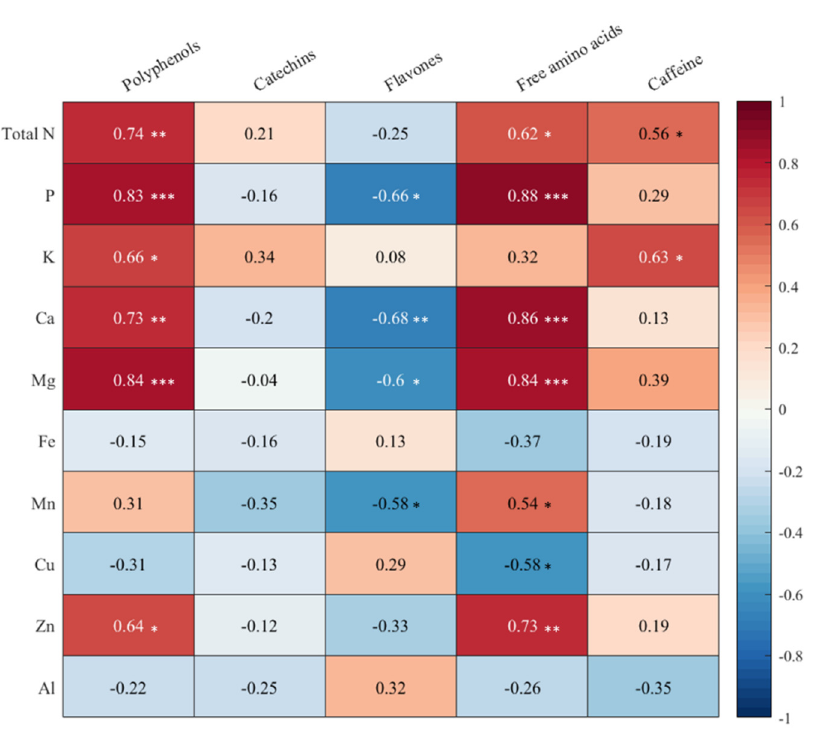
Figure 4. Heatmap of the correlation coefficient between element nutrients and chemical composi- tions in Sijichun leaves. The chemical compositions are depicted on the horizontal axis, while the elements are depicted on the vertical axis. *: p < 0.05; **: p < 0.01; ***: p < 0.0001.